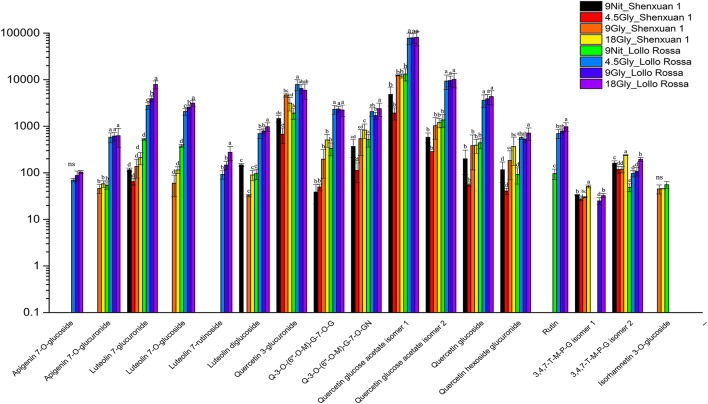
Effects of nitrate and glycine supply on the relative ratios of flavonoid derivatives in lettuce leaf extracts. Different small letters indicate significant differences (p < 0.05) and “ns” indicates non-significant differences (p ≥ 0.05; LSD analysis, n = 3). Q-3-O-(6″-O-M)-G-7-O-G, quercetin 3-O-(6″-O-malonyl)-glucoside 7-O-glucoside; Q-3-O-(6″-O-M)-G-7-O-GN, quercetin 3-O-(6″-O-malonyl)-glucoside 7-O-glucuronide; 3,4,7-T-M-P-G isomer 1, 3,4,7-trihydroxy-5-methoxy-8-prenylflavan 7-O-beta-D-glucopyranoside isomer 1; and 3,4,7-T-M-P-G isomer 2, 3,4,7-trihydroxy-5-methoxy-8-prenylflavan 7-O-beta-D-glucopyranoside isomer 2.